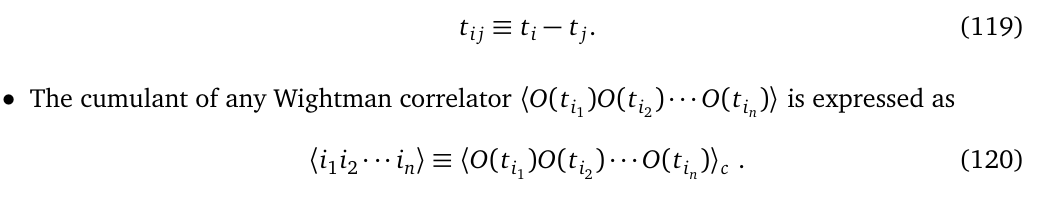
Figure 8: Feynman diagram contributing to the 2-point cumulants